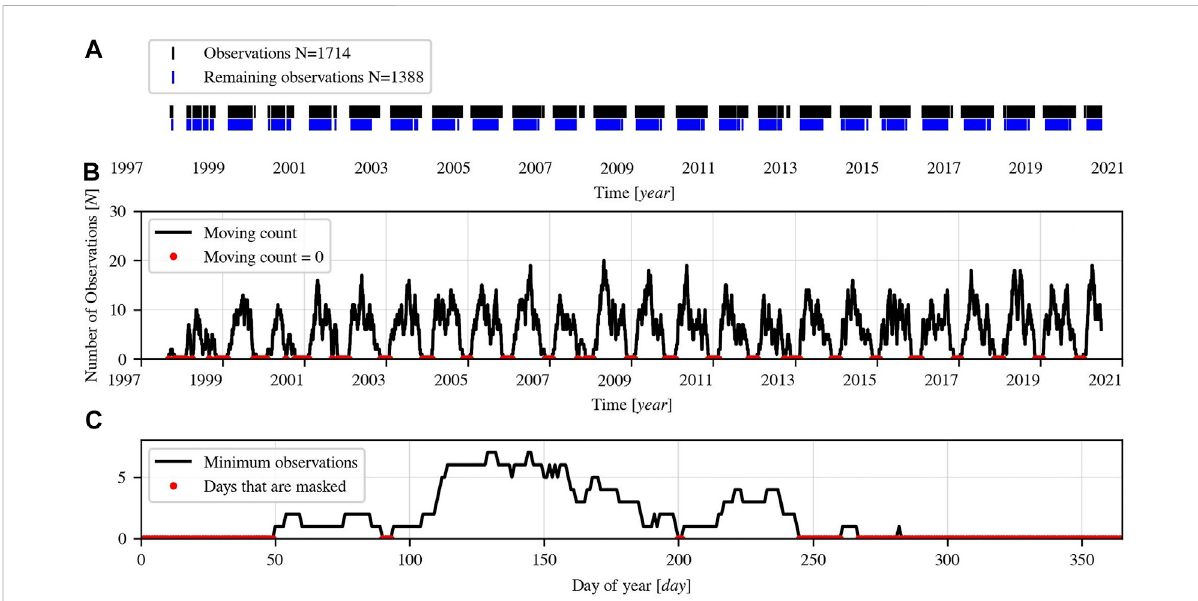
FIGURE 2 The Temporal Gap Detection Method (TGDM) applied as a showcase to one pixel located in the North Sea (using a time window length of 27 days): (A) Original observations for this pixel (in black) and those remaining after TGDM is applied (in blue). (B) Full time series of the summed number of observations for this pixel within the time window calculated per day. Time periods without observations are marked in red. (C) The minimumnumberofobservationsofthefulltimeperiodshownin (B) asafunctionofthe ‘ Dayofyear ’ .Daysoftheyearwithoutobservations(in red) are masked in every year for the full time